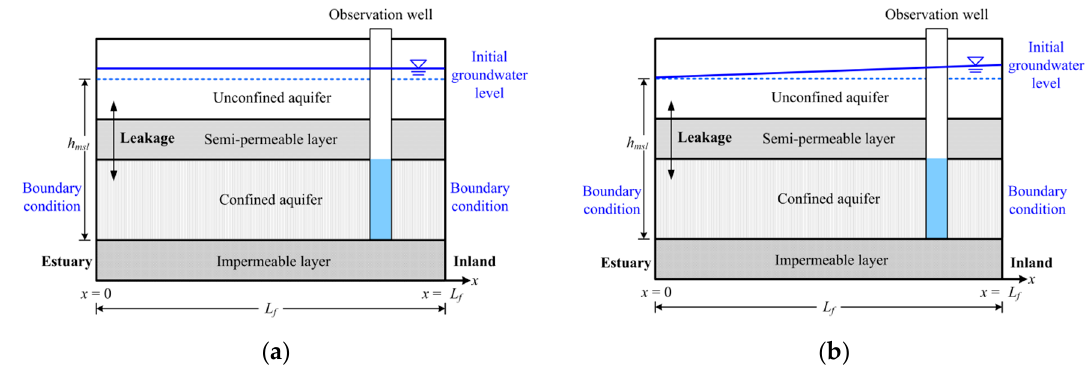
Figure 8. Schematic of finite coastal confined aquifer: ( a ) case A: constant initial hydraulic head; ( b ) case B: inclined initial hydraulic head.